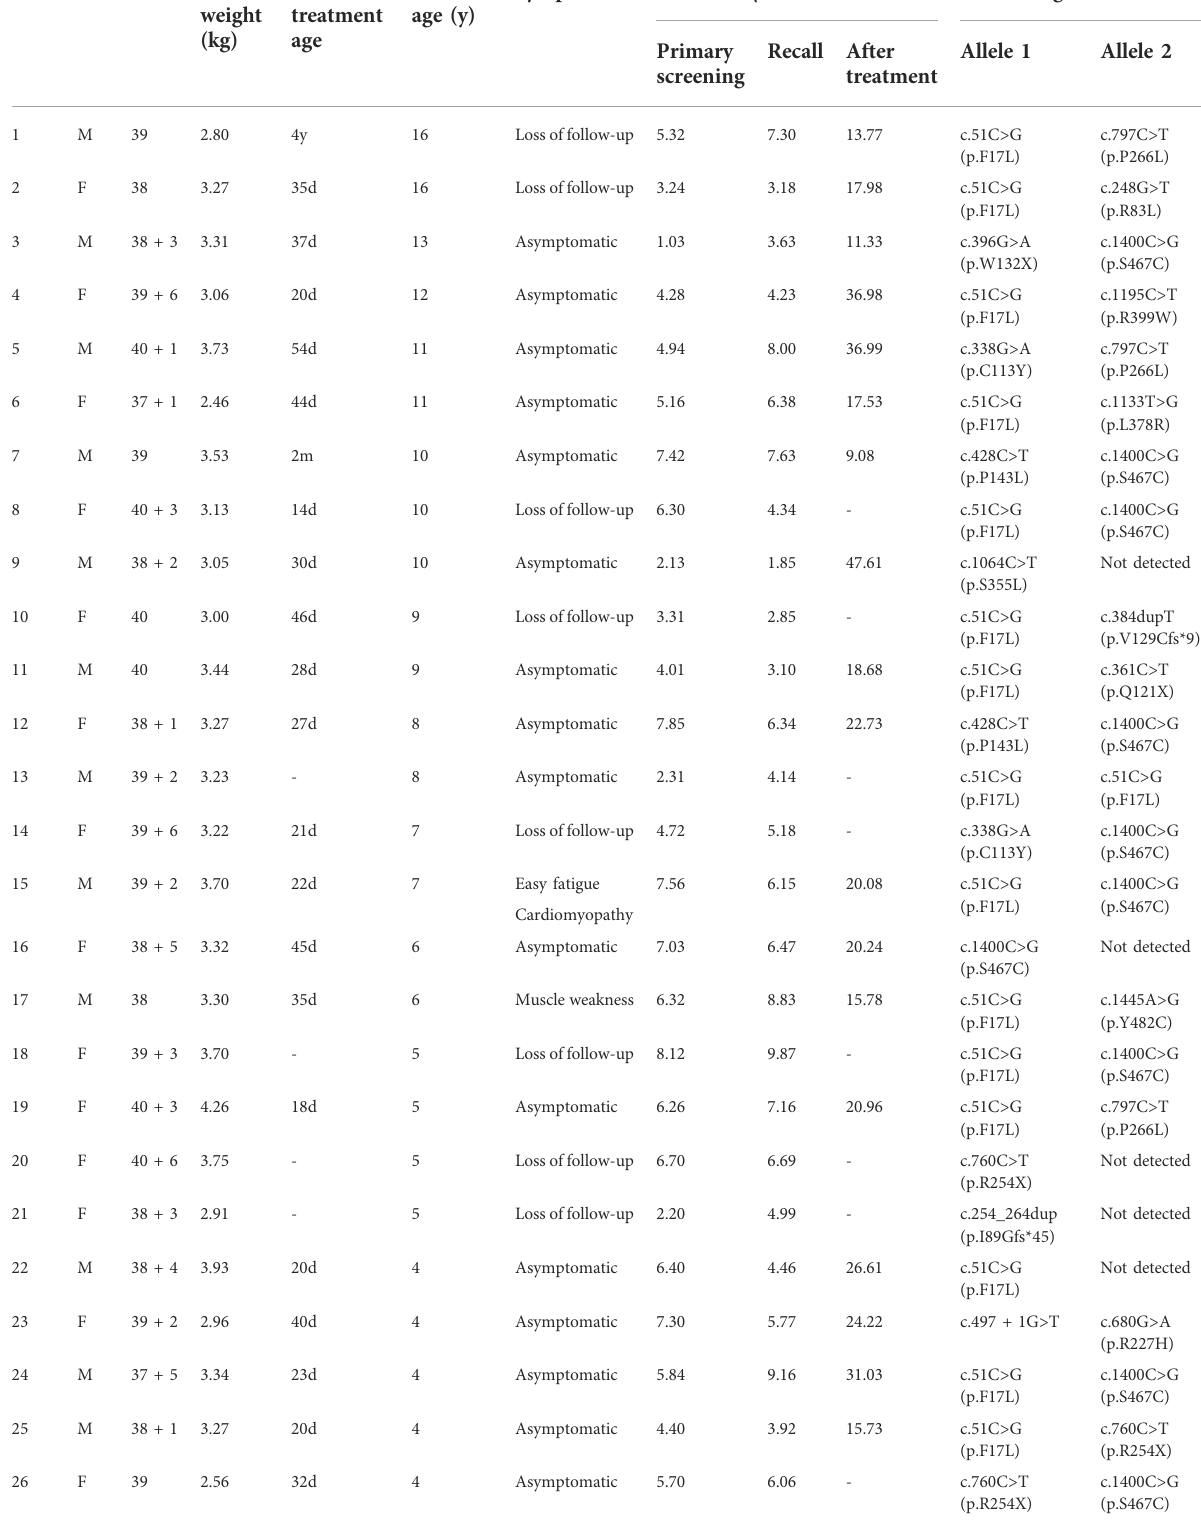
TABLE 1 Clinical, biochemical, and molecular characteristics of PCD patients identi fi ed by